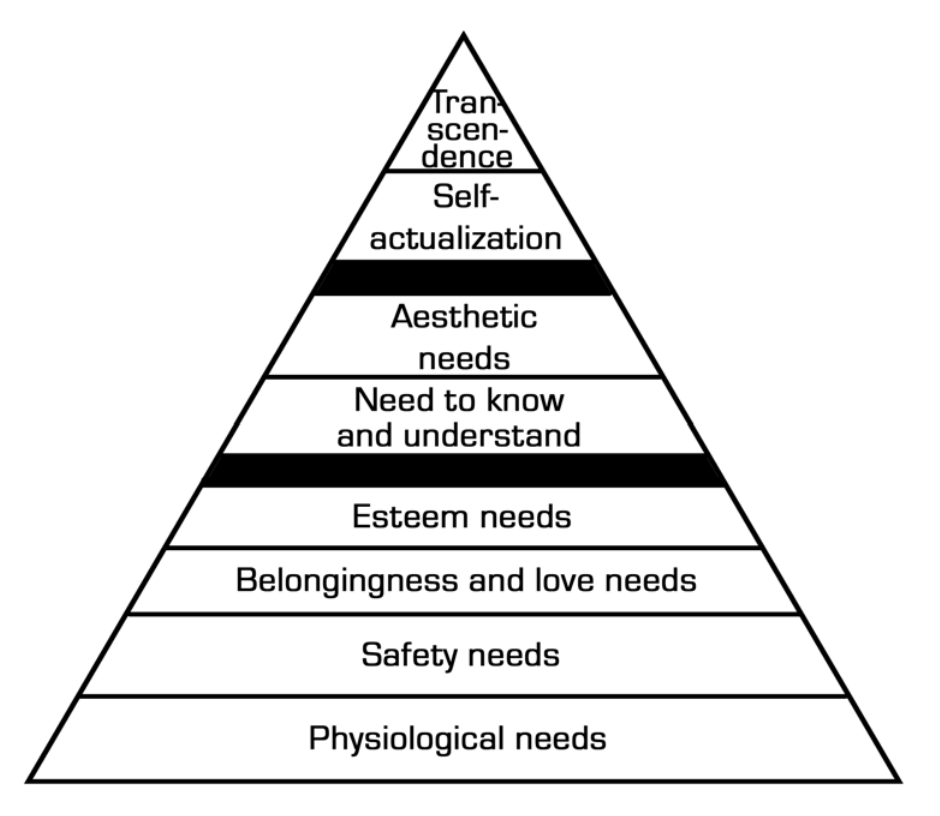
FIGURE 1 . Maslow’s hierarchy of